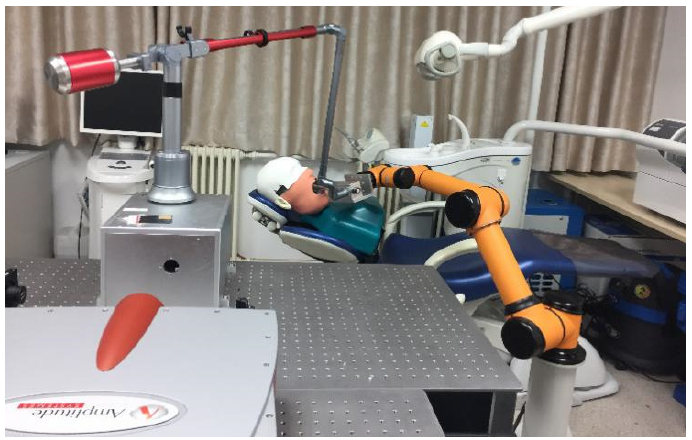
Figure 1. Automatic tooth preparation robot.